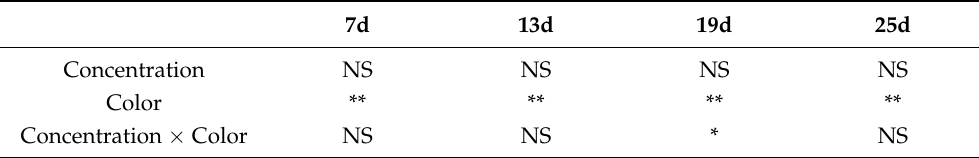
Table A2. Two-way ANOVA conducted shows the effects of concentration, color, and their interaction on the chlorophyll a content in M. aeruginosa cells.